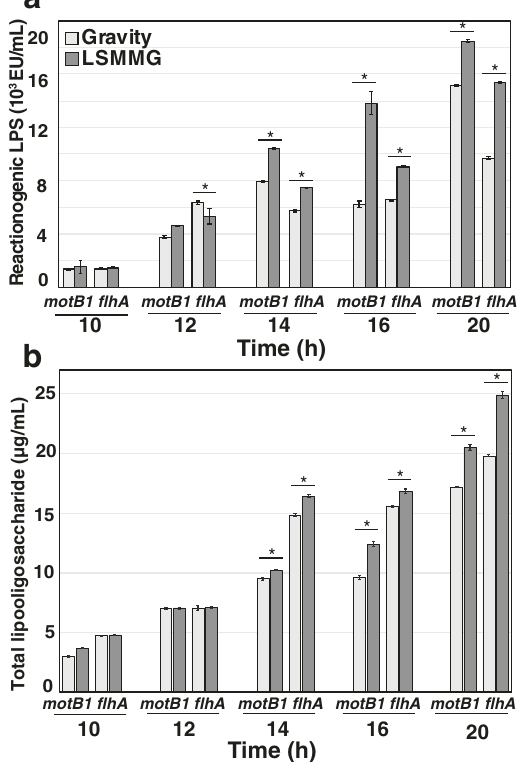
Fig. 3 Lipopolysaccharide (LPS) shedding of V. fi scheri motility mutants motB1 and fhlA under low-shear modeled microgravity (LSMMG) conditions compared to gravity controls. a Reactiono- genic LPS as measured by the limulus amebocyte lysate endotoxin assay under gravity (light gray) and LSMMG (dark gray) conditions. b Total LPS levels as measured by the Purpald assay between LSMMG and gravity (G) conditions. Error bars indicate the standard error of the mean. Asterisks indicate signi fi cant differences between the data sets ( p < 0.05; Mann – Whitney U